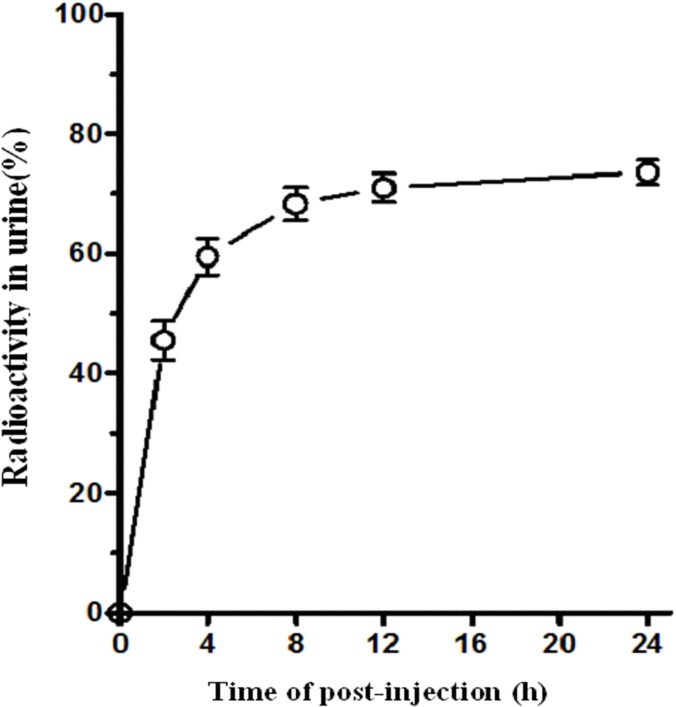
Averaged time-activity curve of 99mTc-RGD-BBN in urine for all healthy volunteers.Error bars indicate standard deviations.